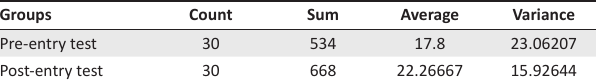
TABLE 1: Total number of students and the mean scores of the two tests.